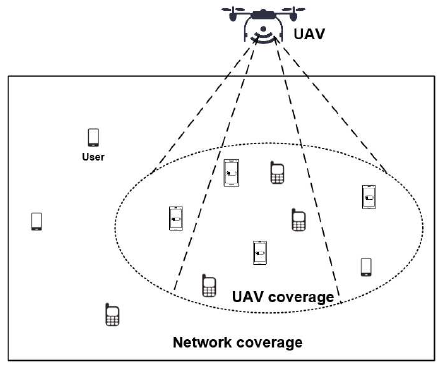
Figure 4. A network coverage of an embedded